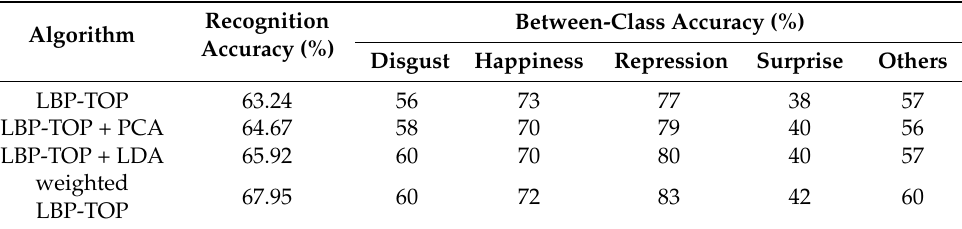
Table 8. Comparison of dimension reduction results (CASME II).